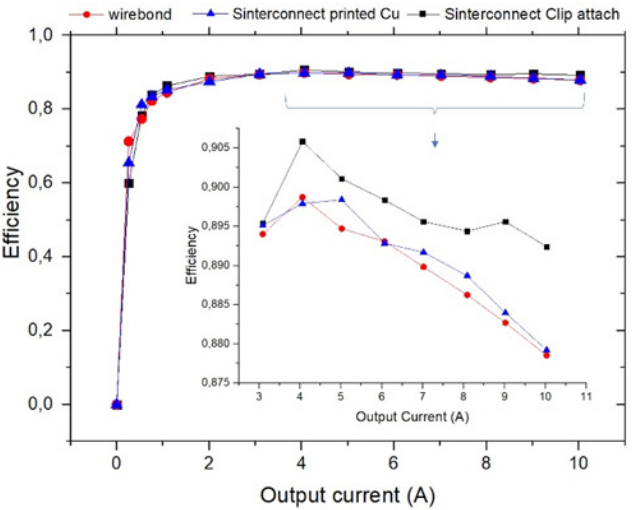
Figure 8. Measured buck converter efficiency